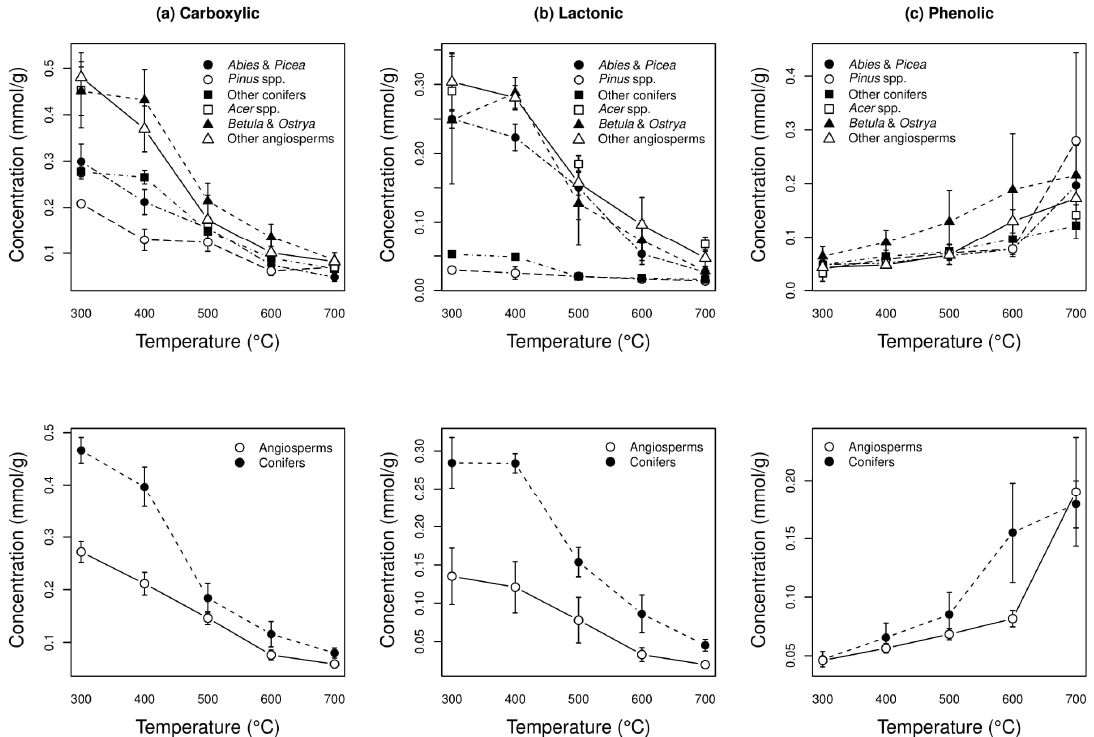
Figure 3. Concentrations of surface functional groups as a function of temperature grouped by six taxonomic groups and grouped by conifers vs. angiosperms: Carboxylic ( a ), lactonic ( b ), and phenolic ( c ), in 19 temperate tree species: Conifer species ( n = 9) and angiosperm species ( n = 10).